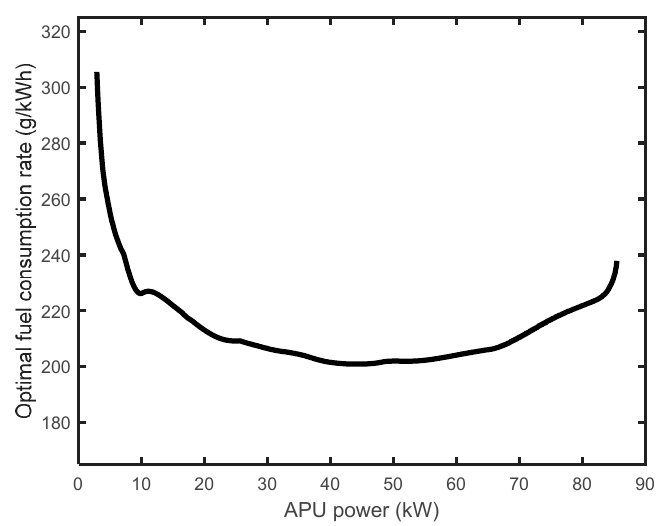
Figure 5. Relationship between APU power and fuel consumption rate in best operation curve.